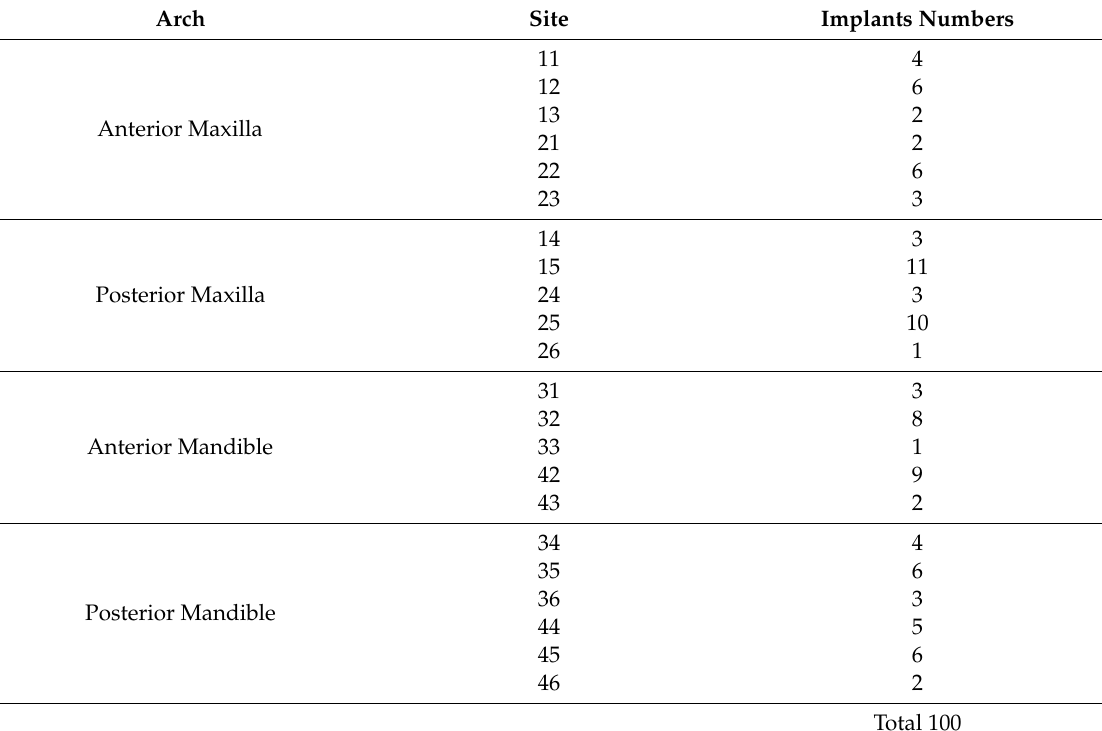
Table 1. The 100 dental implants in the maxilla or mandible site